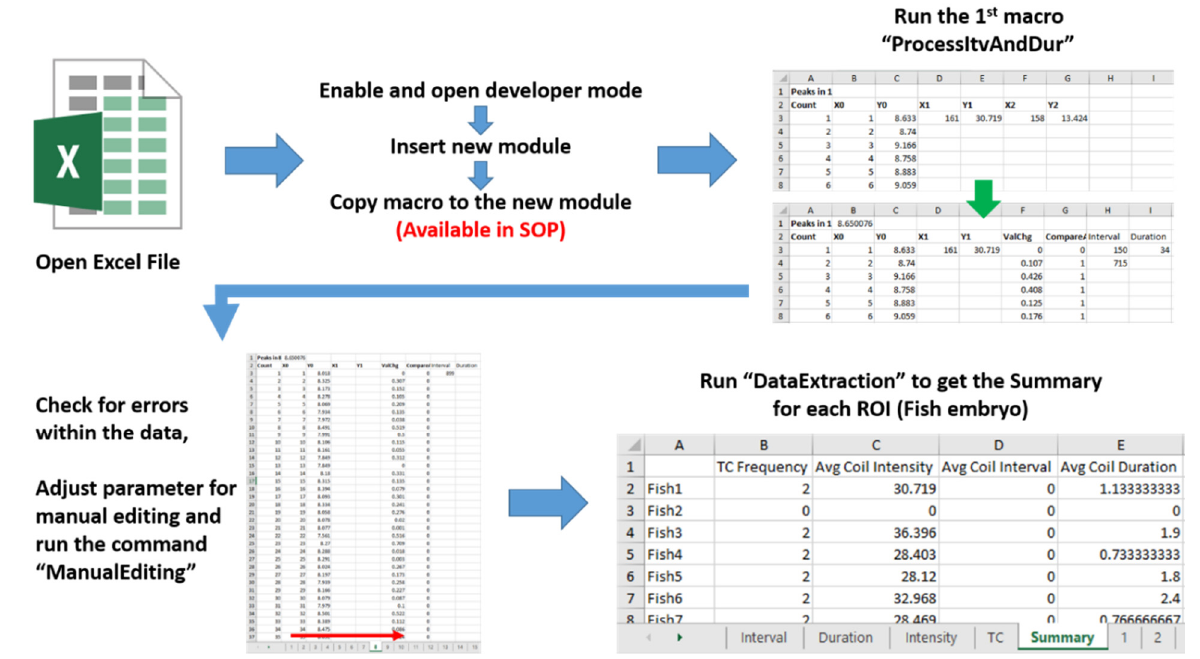
Figure 5. Workflow of tail coiling data collection automation step using Microsoft Excel VBA (Visual Basic for Applications). Three important macro scripts of ProcessitvAndDur, ManualEditing and DataExtraction were developed to boost data calculation automation.